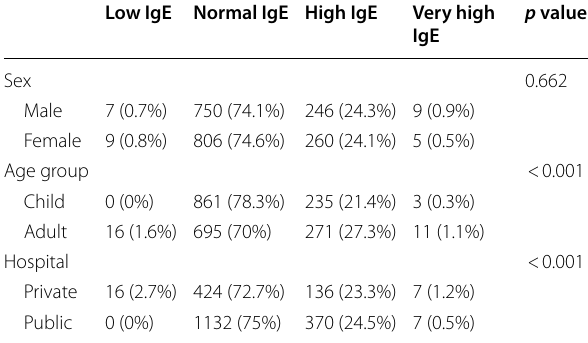
Data presented as number, percentage; significant p value <